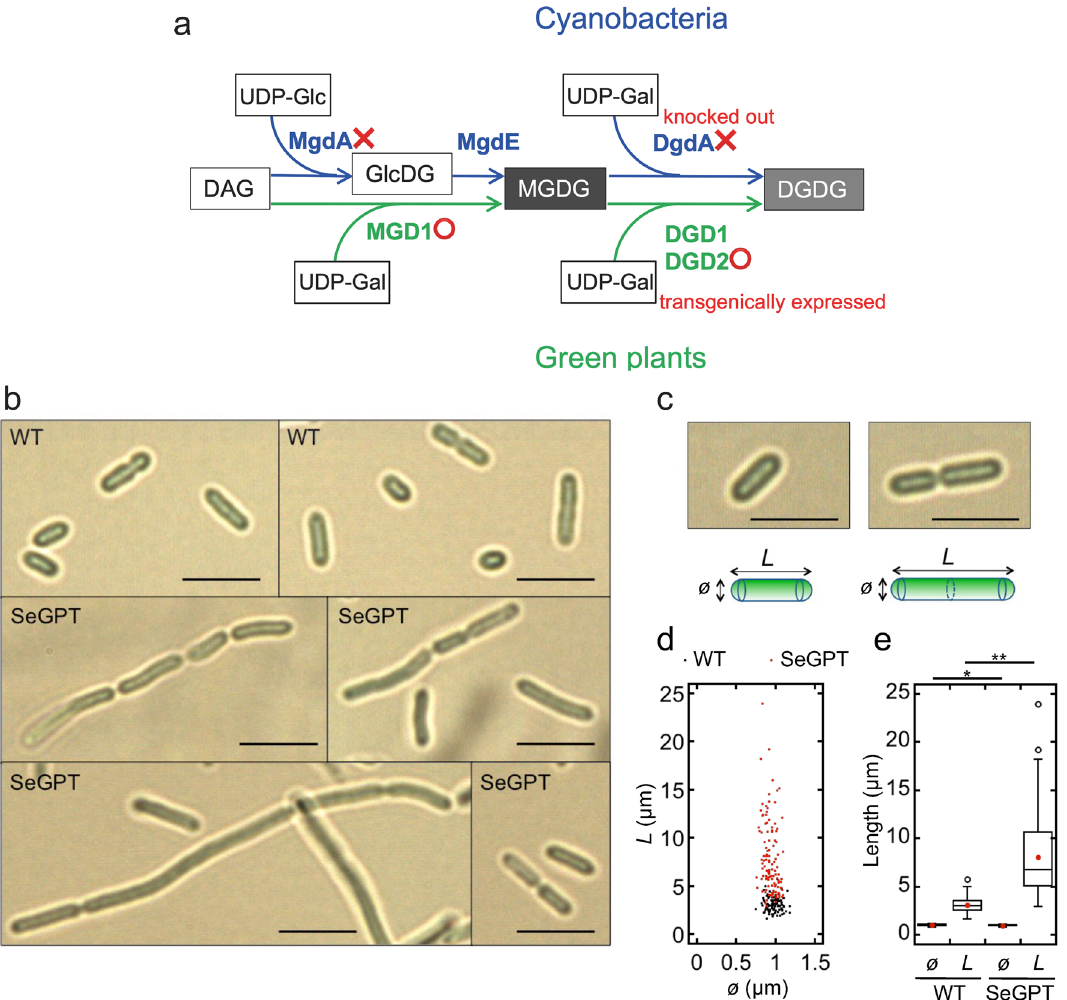
Figure 1. Schematic diagram of galactolipid-biosynthetic pathways in SeGPT ( a ), bright-field microscope images of Synechococcus ( b ) and measurements of cell size ( c–e ). ( a ) Lipid molecules and nucleotide sugar donors are depicted in boxes. The upper depicts a pathway in cyanobacteria and the lower depicts one in green plants. In SeGPT, two endogenous genes, encoding MgdA and DgdA, were knocked-out (red crosses) and two plant-type genes, encoding MGD1 from Cucumis sativus and DGD2 from Arabidopsis thaliana were transgenically expressed (red circles). DAG, diacylglycerol; GlcDG, monoglucosyl diacylglycerol; MGDG, monogalactosyldiacylglycerol; DGDG, digalactosyldiacylglycerol; UDP-Glc, uridine diphosphate-glucose; UDP- Gal, uridine diphosphate-galactose. Using the microscopic images of cells at the mid-log phase ( b ), cell length ( L ), and diameter ( ø ) were compared between the WT and SeGPT ( c ). Cell particles connected in a filamentous manner were counted as one cell ( c , right). Results are presented in dot plots ( d ) and box plots ( e ). Black and red dots indicate the WT and SeGPT, respectively ( d ). Red circles in e indicate the averages (n = 102 for the WT; n = 118 for SeGPT). Scale bars: 5 µm ( b , c ). The asterisks indicate statistical significance (* P < 0.001, ** P < 0.1^25, Welch’s